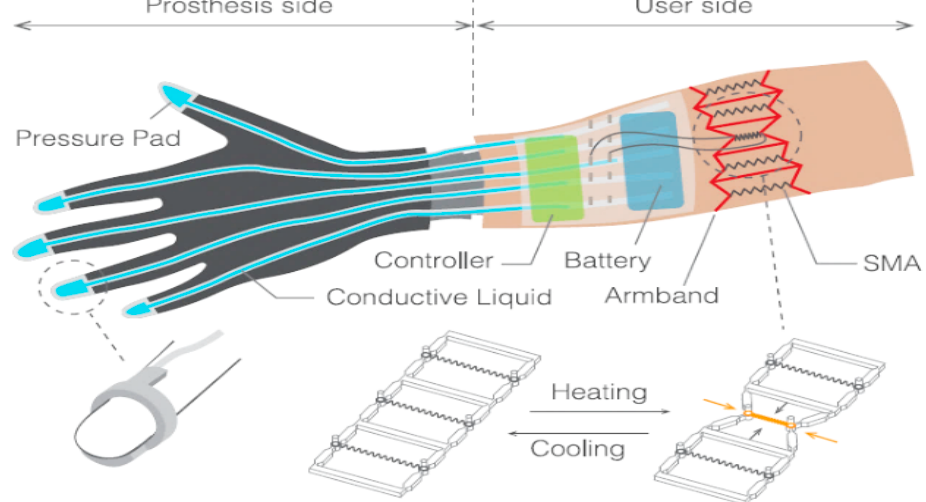
Figure 15. Schematic of B: Ionic glove, constituted by pressure pads, which contain conductive fluid applied to the prosthesis’ fingertip, a battery-powered fluidic controller, and an armband equipped with SMA actuators, worn by the user’s remaining limb to softly squeeze their arm [119]. Pressure pads were attached to the glove’s fingers, which contain a conductive fluid.